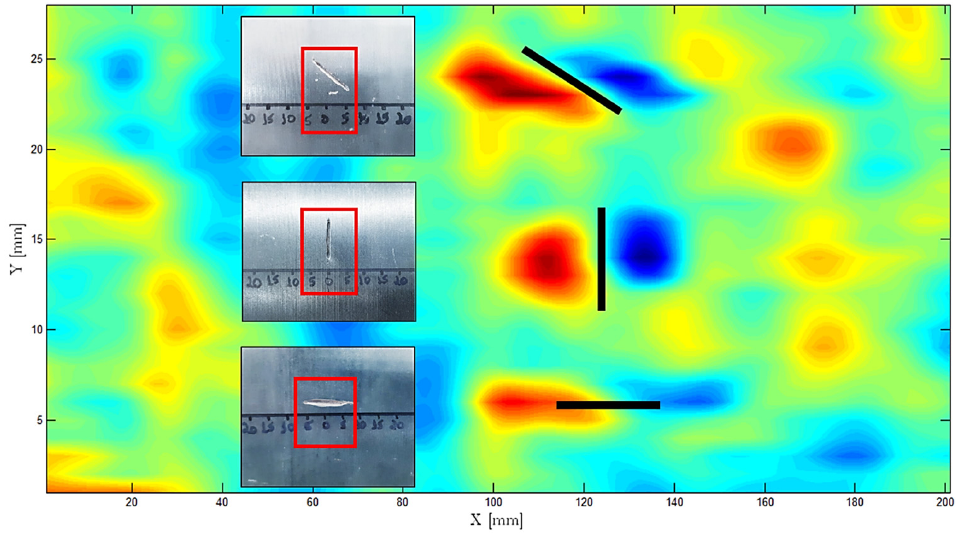
Figure 15. C-scan output signal operating the PCB probe for pipe base material at 1 MHz at 240